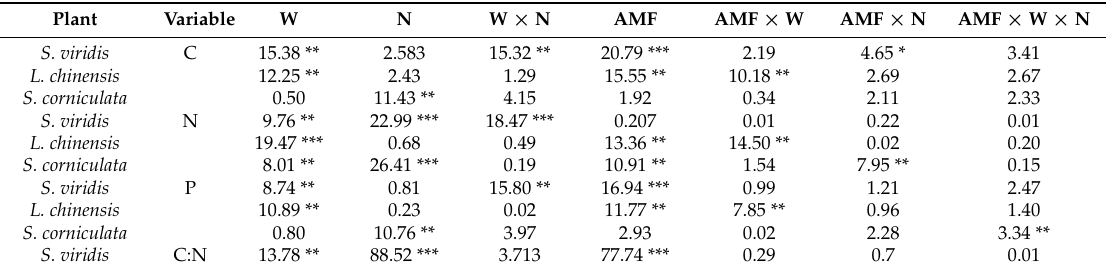
Table 2. Results of three-way factorial analyses of variance (ANOVAs) of the effects of warming, N input and arbuscular mycorrhizal fungi (AMF) on plant C, N, and P contents and ratios of C:N, C:P, and